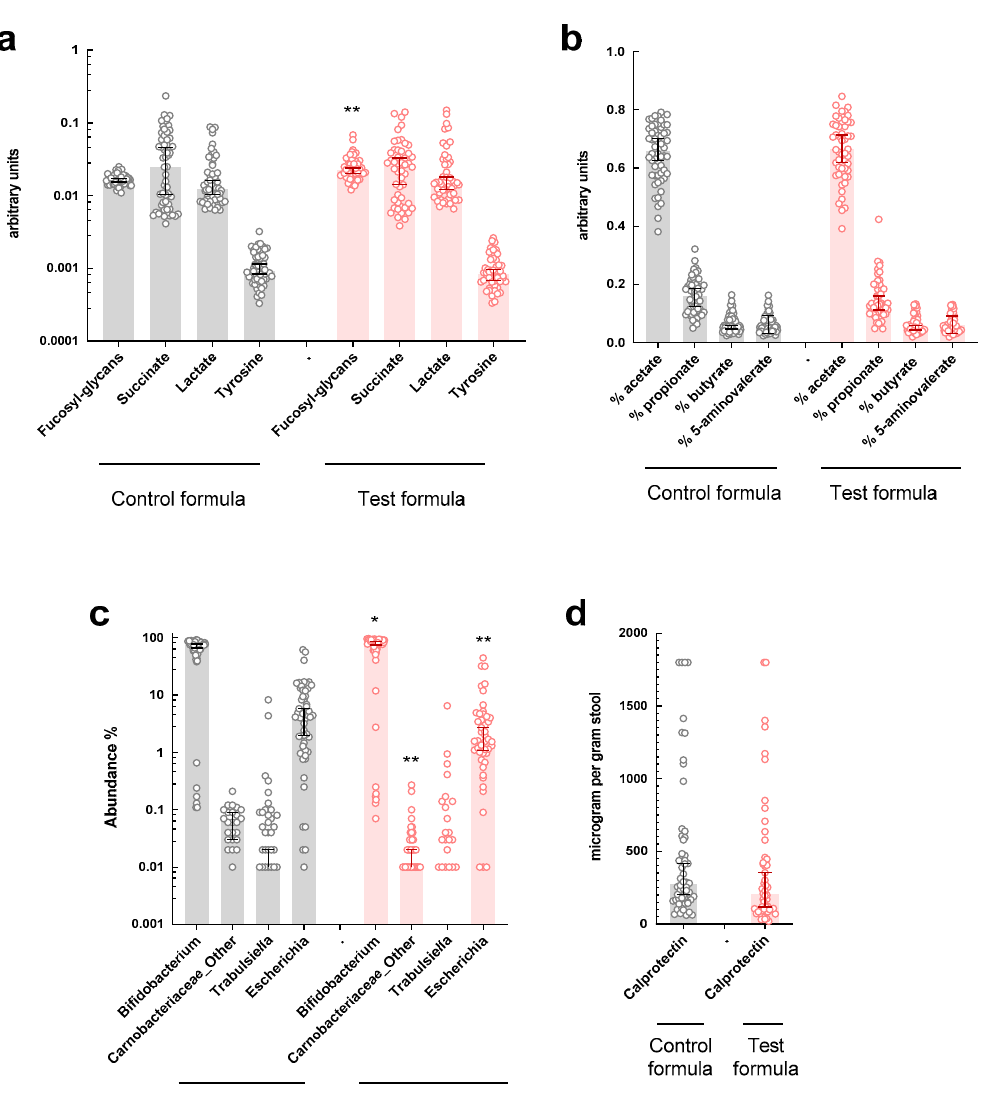
Figure 3. Comparison of the identified main features from the sPLS-DA model by feeding group: ( a , b ) relative abundance of metabolites; ( c ) relative abundance of microbial taxa; ( d ) concentration of calprotectin. ( n = 106; * indicate p < 0.05, ** p < 0.01 by non-parametric t -test).